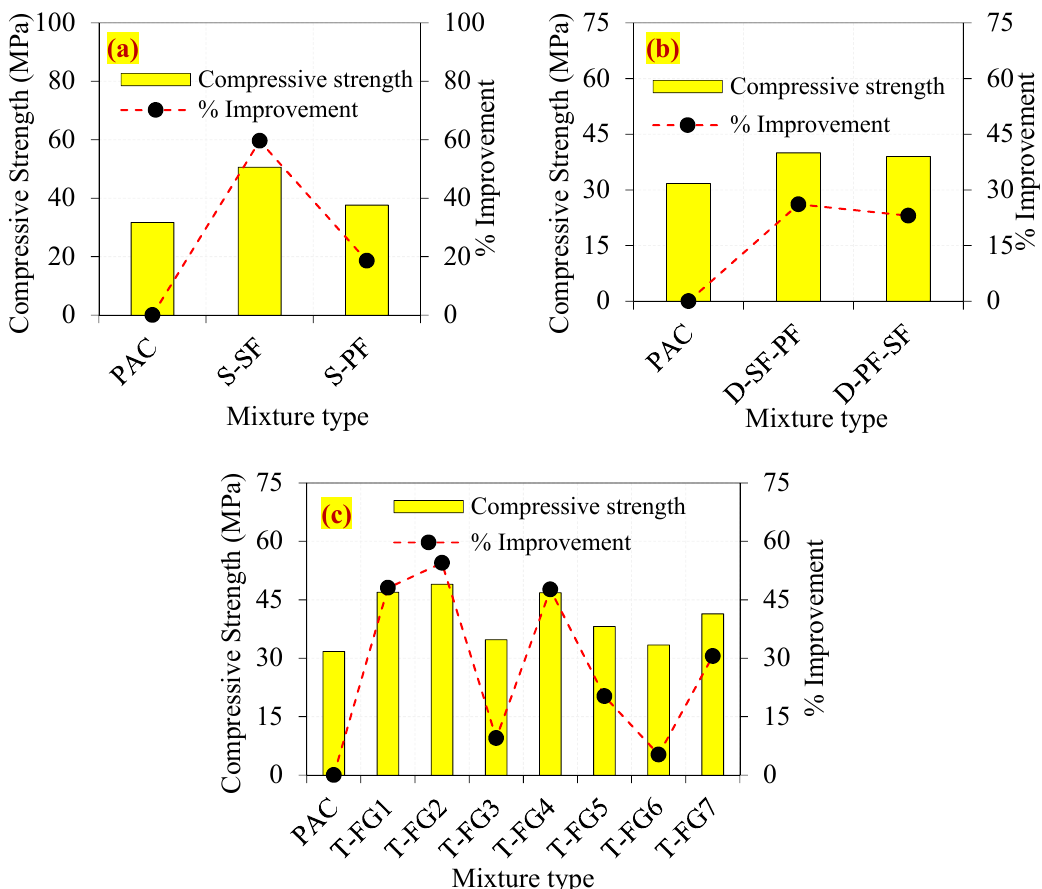
Figure 7. The observed compressive strengths of the FTSFC ( a ) Single layer ( b ) Double layer ( c ) Triple layer.